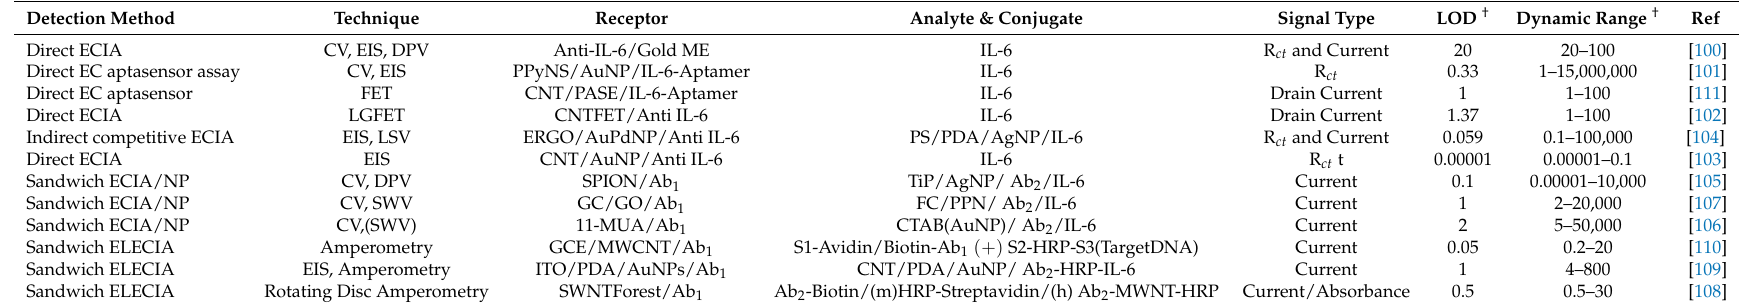
Table 2. Properties of different types of electrochemical immunoassay-based sensors for IL-6 detection. SWNT = single-walled carbon nanotubes; AuNPs = gold